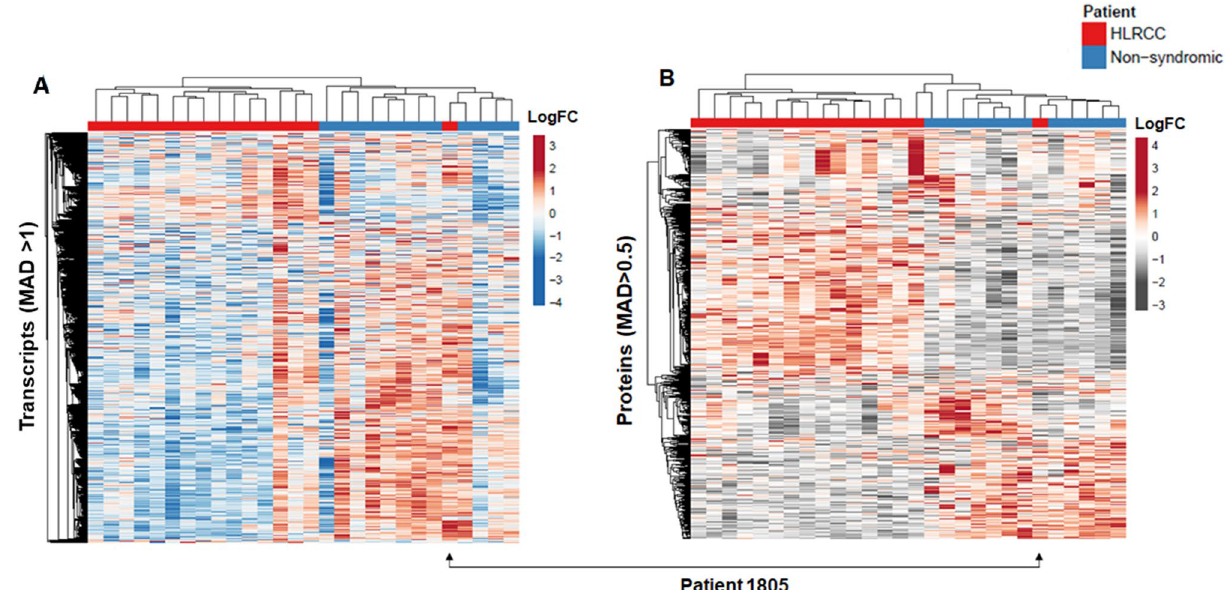
Figure 2. Unsupervised cluster analysis of protein and transcript alterations in uterine leiomyomas (ULMs) from Hereditary Leiomyomatosis and Renal Cell Cancer (HLRCC) and non-syndromic (NS) patients. Heatmaps detail ( A ) transcripts and ( B ) proteins quantified exhibiting a median absolute deviation (MAD) in total RNA-seq (MAD > 1) or TMT-10 quantitative proteomics (MAD > 0.5) data; clusters organized by correlation and average linkage (ClustVis). Plots reveal one HLRCC patient, designated as 1805, clustering as a non-syndromic